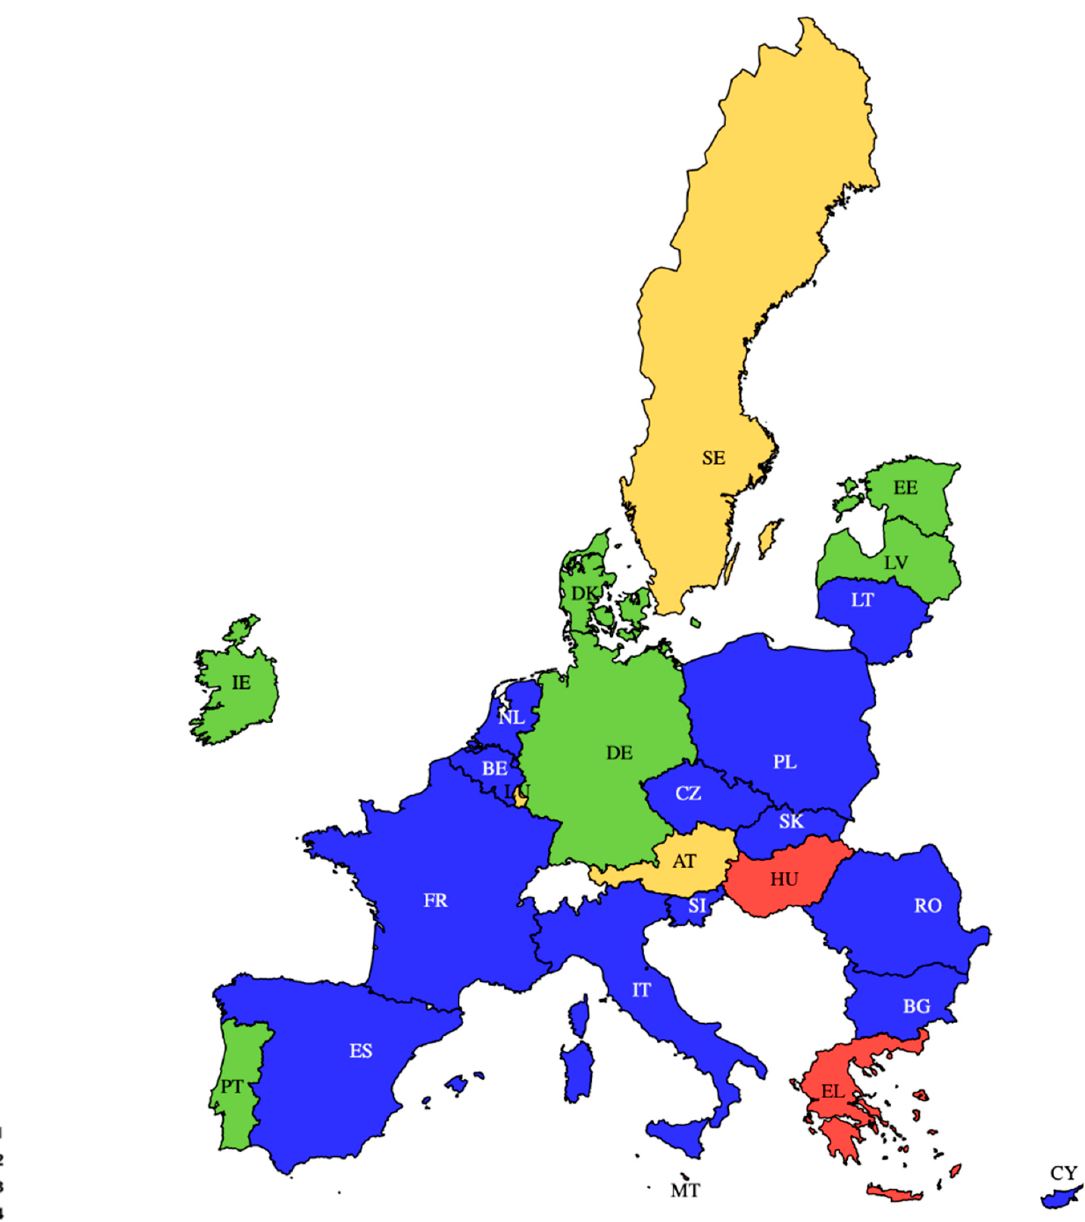
Figure 6. EU countries by typology in 2015.